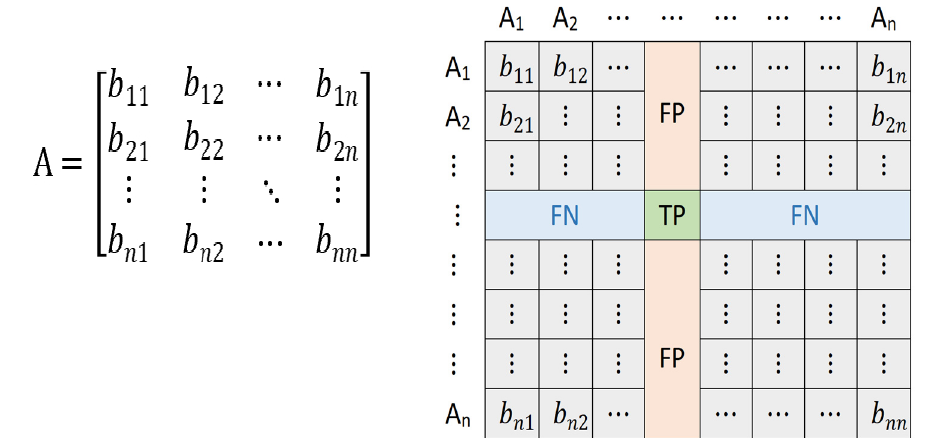
Figure 7. Confusion matrix for a multiclass classification problem.